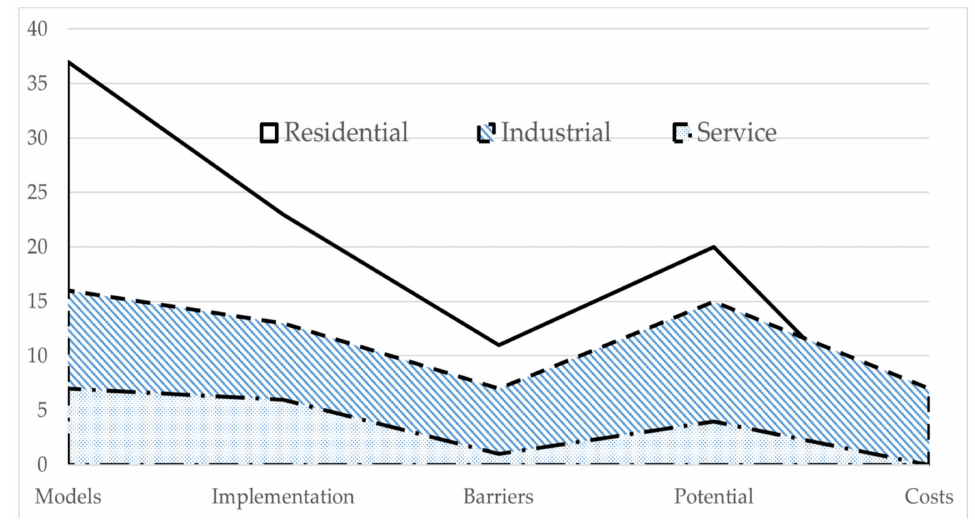
Figure 10. Selected literature distribution by sectors.